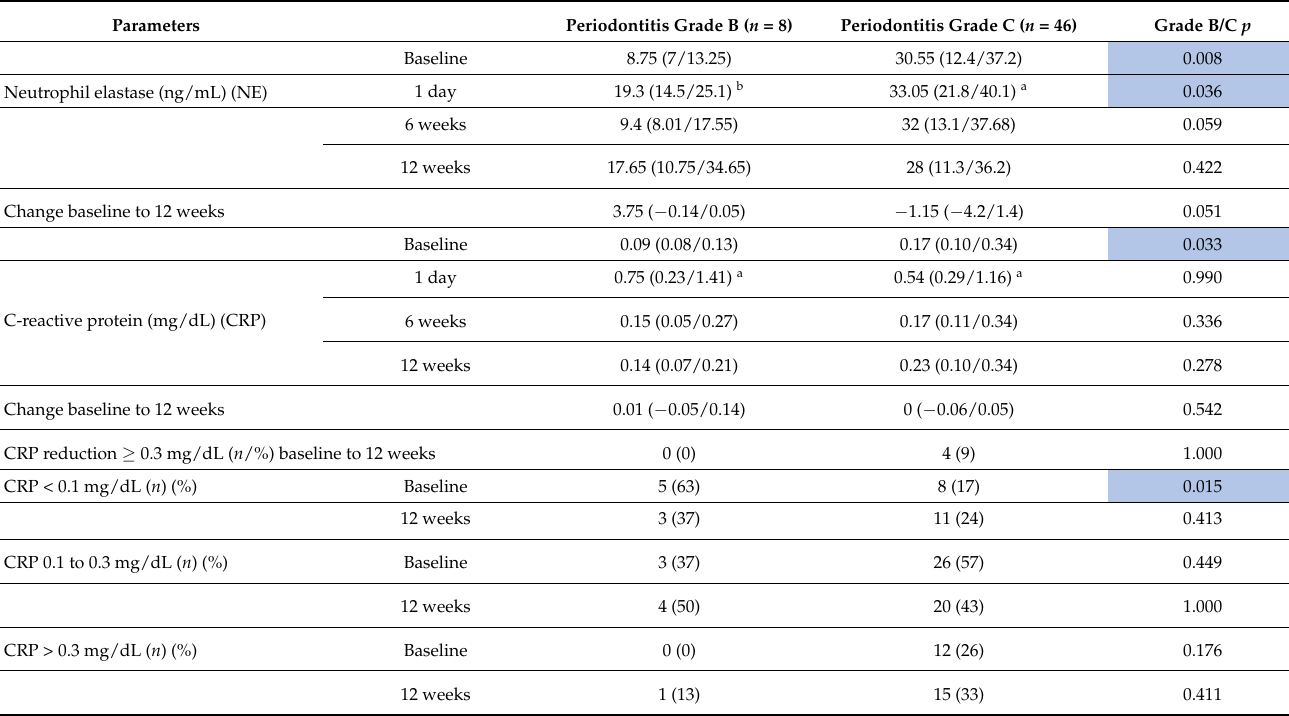
Table 3. Individuals’ neutrophil elastase and C-reactive protein (median (lower/upper quartile)).